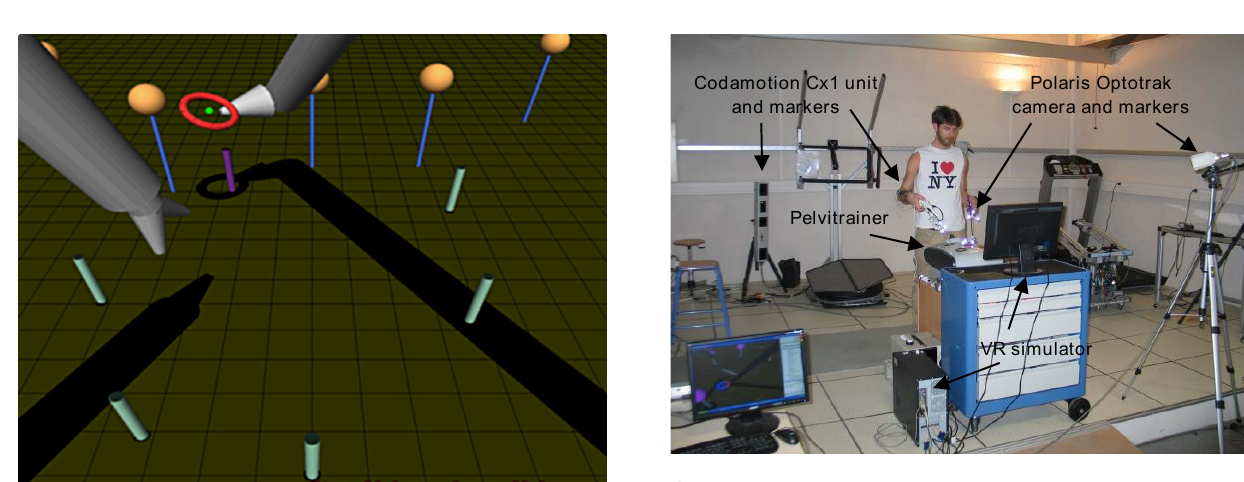
Figure 4. Overview of the experimental setup. placed on the pin after a reorientation of the end effector. The chronometer is stopped when the ring is released on the